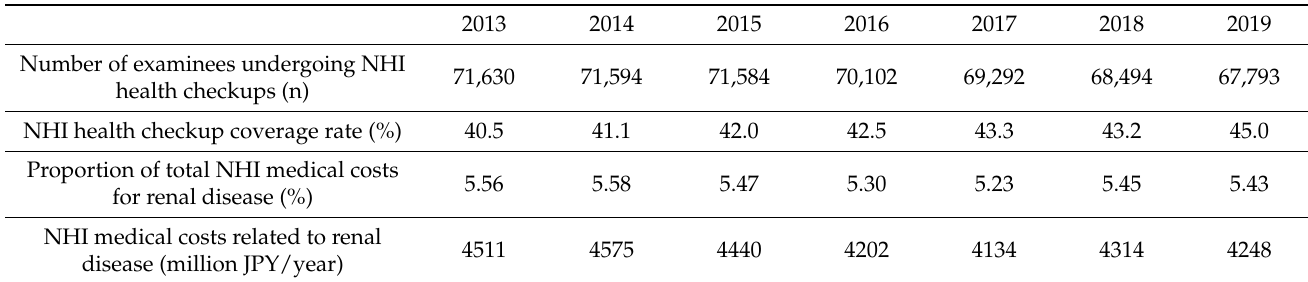
Table 1. Changes in factors related to NHI health checkups and medical costs.